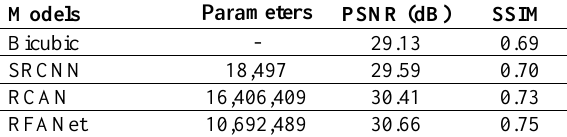
Table 1. Performance of different super-resolution methods